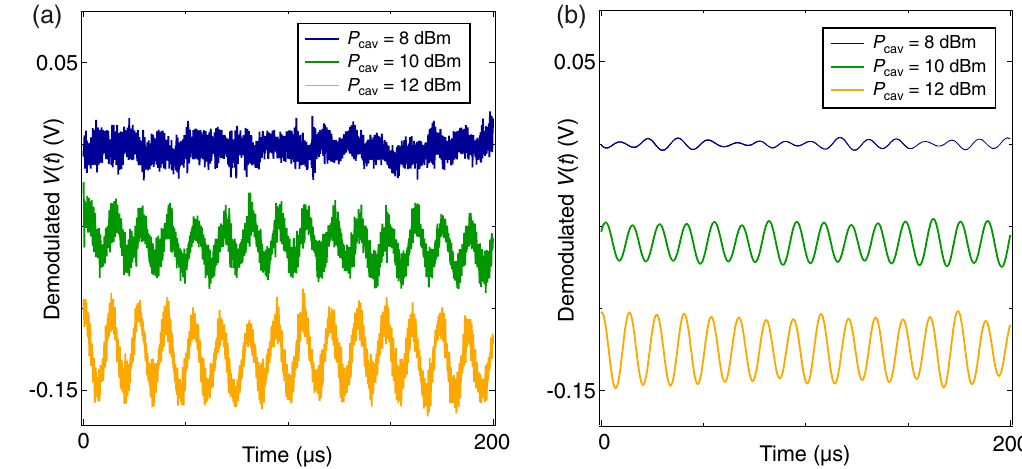
FIG. 9. The demodulated cavity output signal before (a) and after (b) filtering as a function of time for input powers of 8, 10, and 12 dBm to the cavity with 0.25 W white-noise input from port 3. The traces are vertically offset for clarity.